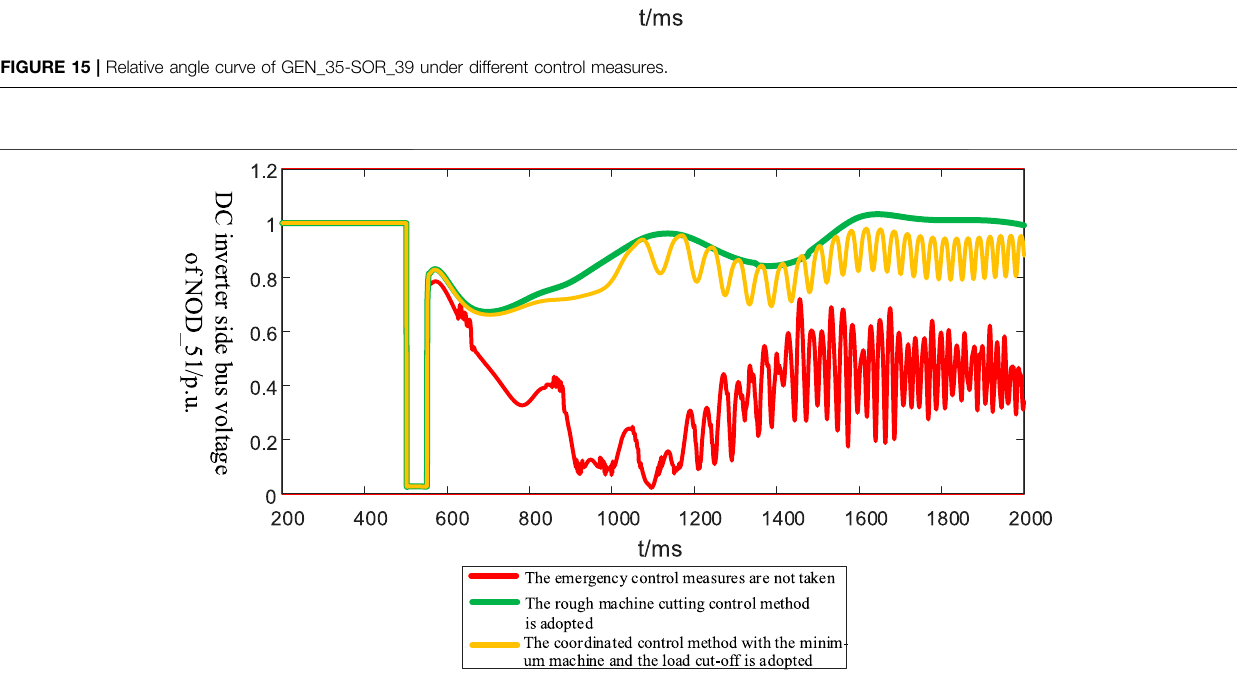
FIGURE 16 | Voltage of NOD_51 under different control